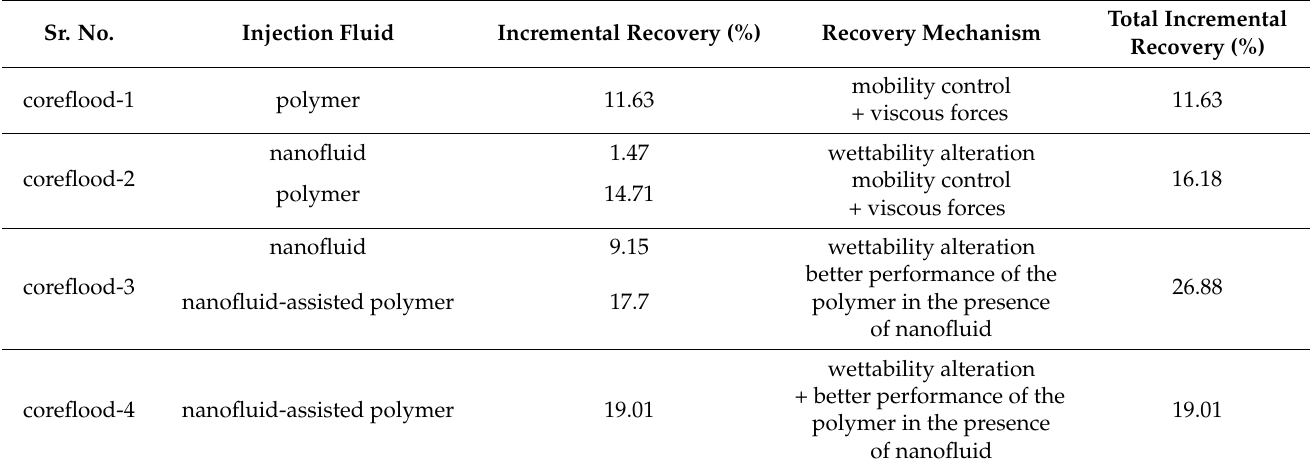
Table 11. The relative contribution of wettability alteration and polymer’s viscosity